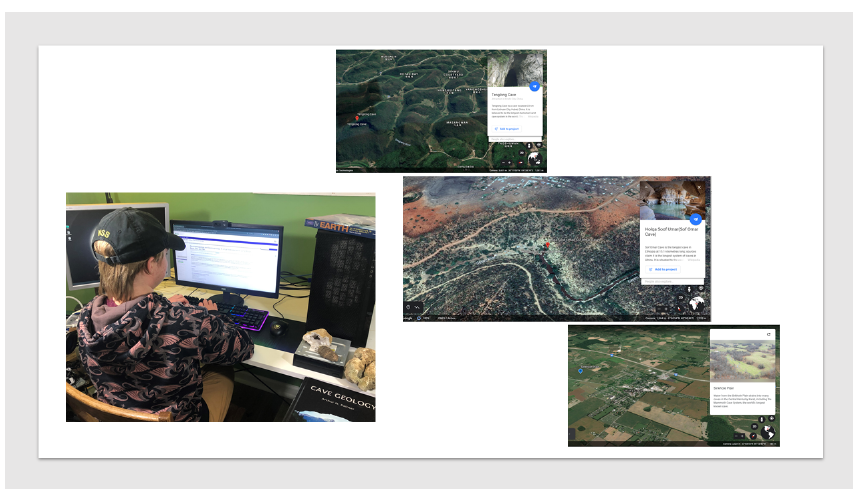
Figure 2. Student choosing a karst area to study. Images of the © Google Earth pages for Tenglong Cave, China, Sof Omar Cave, Ethiopia, and the Central Kentucky Sinkhole Plain, USA, as examples. Photo by the author.